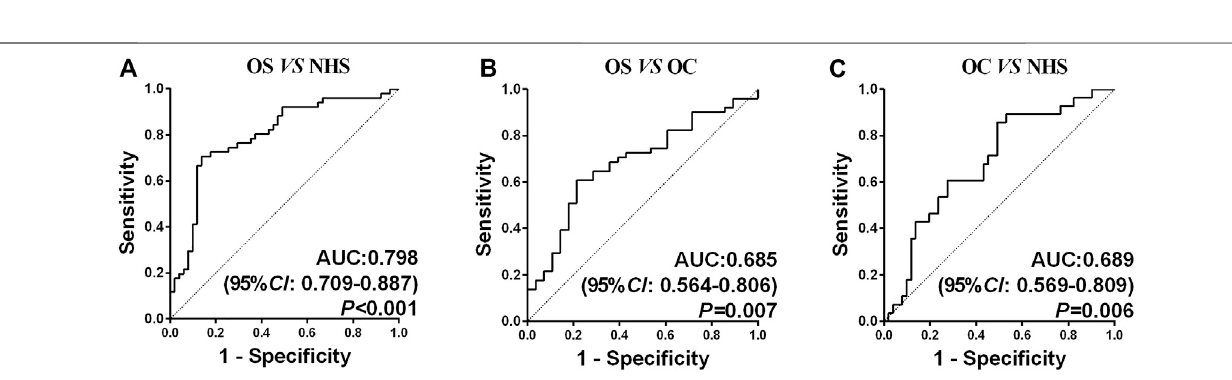
Frontiers in Genetics |